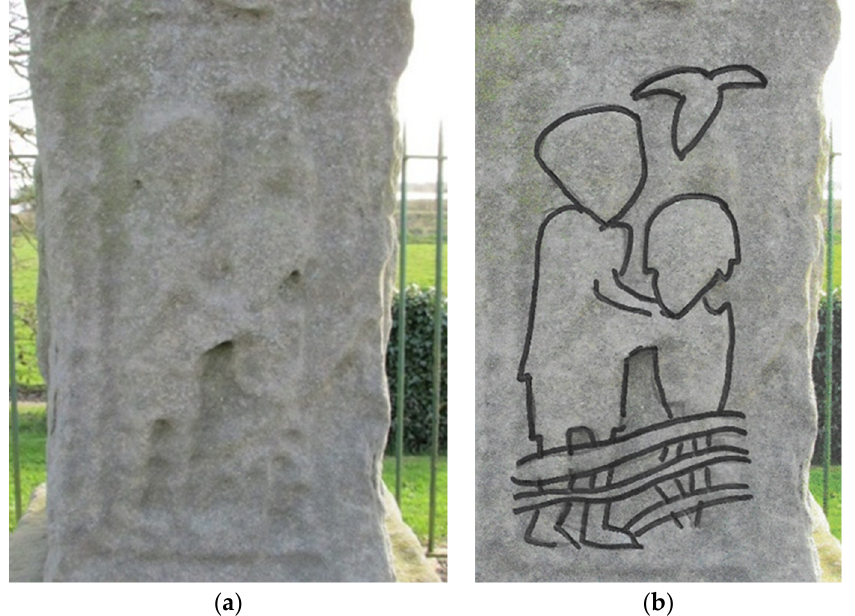
Figure 1 . ( a , b ). Baptism of Christ, N1, Arboe cross. Early ninth century. Arboe, Co. Tyrone. Photograph: Megan Henvey; Interpretive Sketch: Megan Henvey.